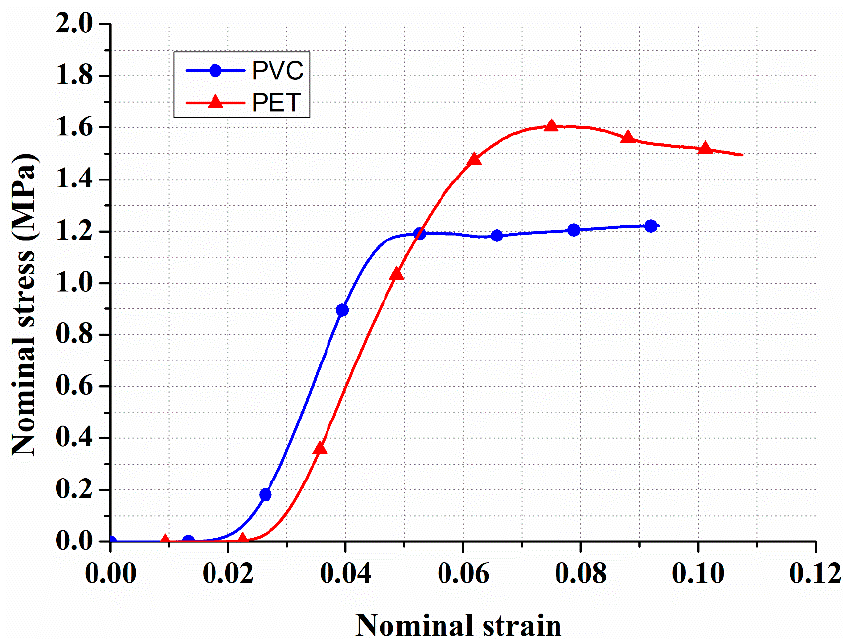
Figure 2. Foams uniaxial compression tests.